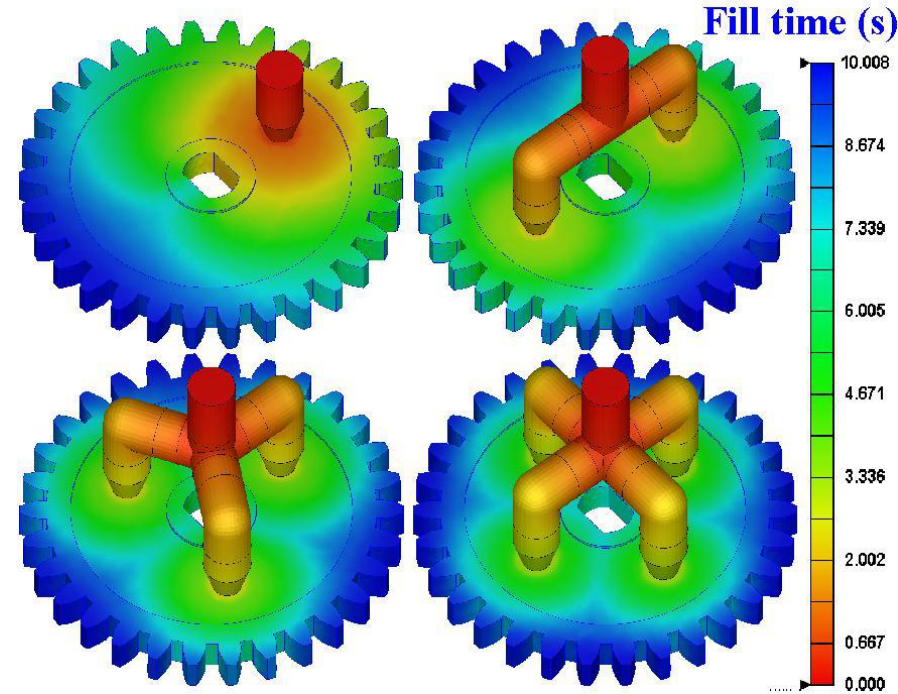
Figure 9. Filling results of different gate numbers.